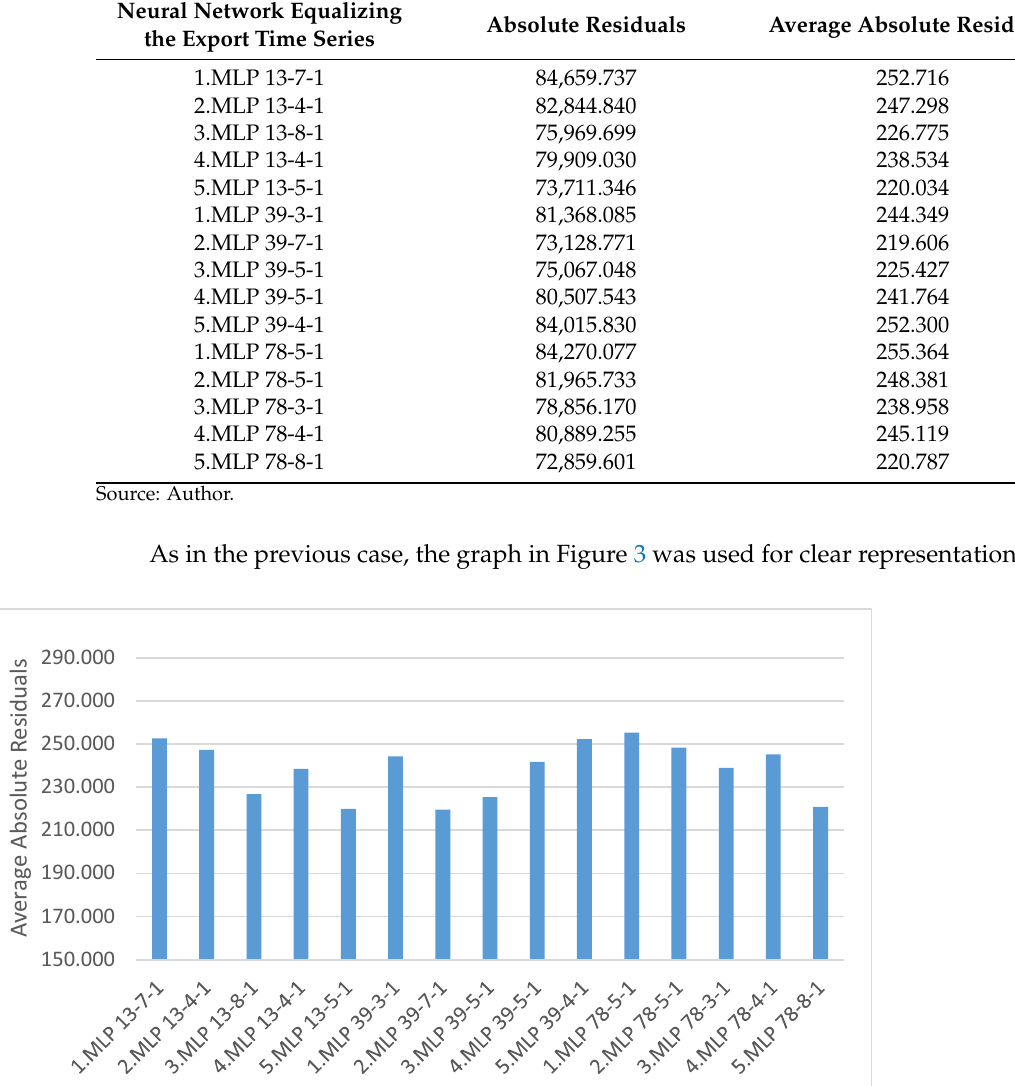
Table 4. Comparison of average absolute residuals of equalized time series of RF import from PRC.